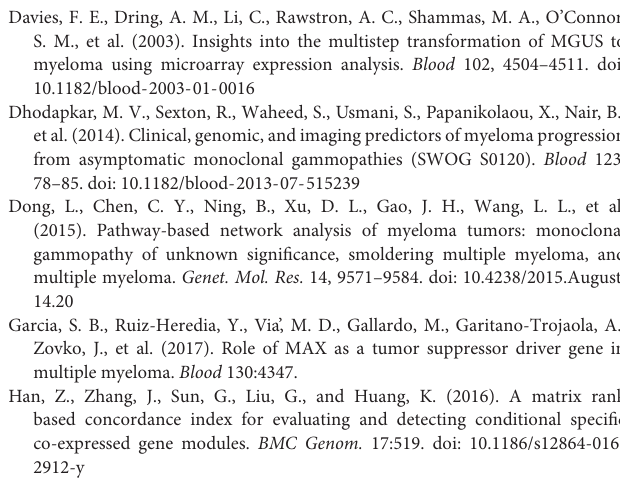
FIGURE S1 | Sample identity distograms of SMM samples produced by Rawcopy. (A) Distogram including GSM777173 that suggests this sample has some relatedness to other samples. (B) Distogram after removing GSM777173. FIGURE S2 | Gene-wise correlation heatmap of the two most highly similar modules in (A) lmQCM ( n = 224) and (B) WGCNA ( n = 393). The correlation coefficients are the absolute value of the Spearman correlation. The median correlation coefficient is higher in lmQCM (0.403) compared to WGCNA (0.344). SCC, Spearman correlation coefficient. FIGURE S3 | Gene-wise correlation heatmap of a normal-specific gene module. The genes in the module were identified by lmQCM in the normal samples. Gene-wise correlation coefficients are calculated from gene expression in each respective condition: (A) Normal, (B) MGUS, and (C) SMM. The correlation coefficients are the absolute value of the Spearman correlation. The genes are more correlated in normal samples and decrease in correlation in MGUS and SMM samples. The CCI values are 0.697, 0.226, and 0.252, respectively. SCC, Spearman correlation coefficient. TABLE S1 | GO BP enrichment results identified by enrichR. The most relevant enrichment terms are included along with the enrichment size and p -value associated with the corresponding